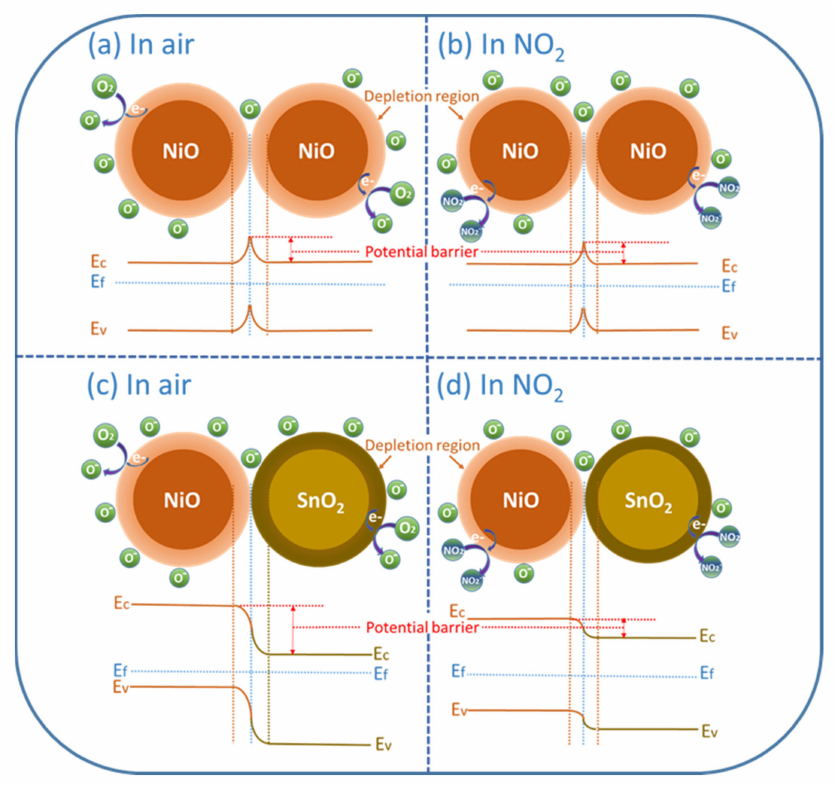
Figure 8. The sensing mechanism of ( a , b ) pristine NiO and ( c , d ) SnO 2 / NiO